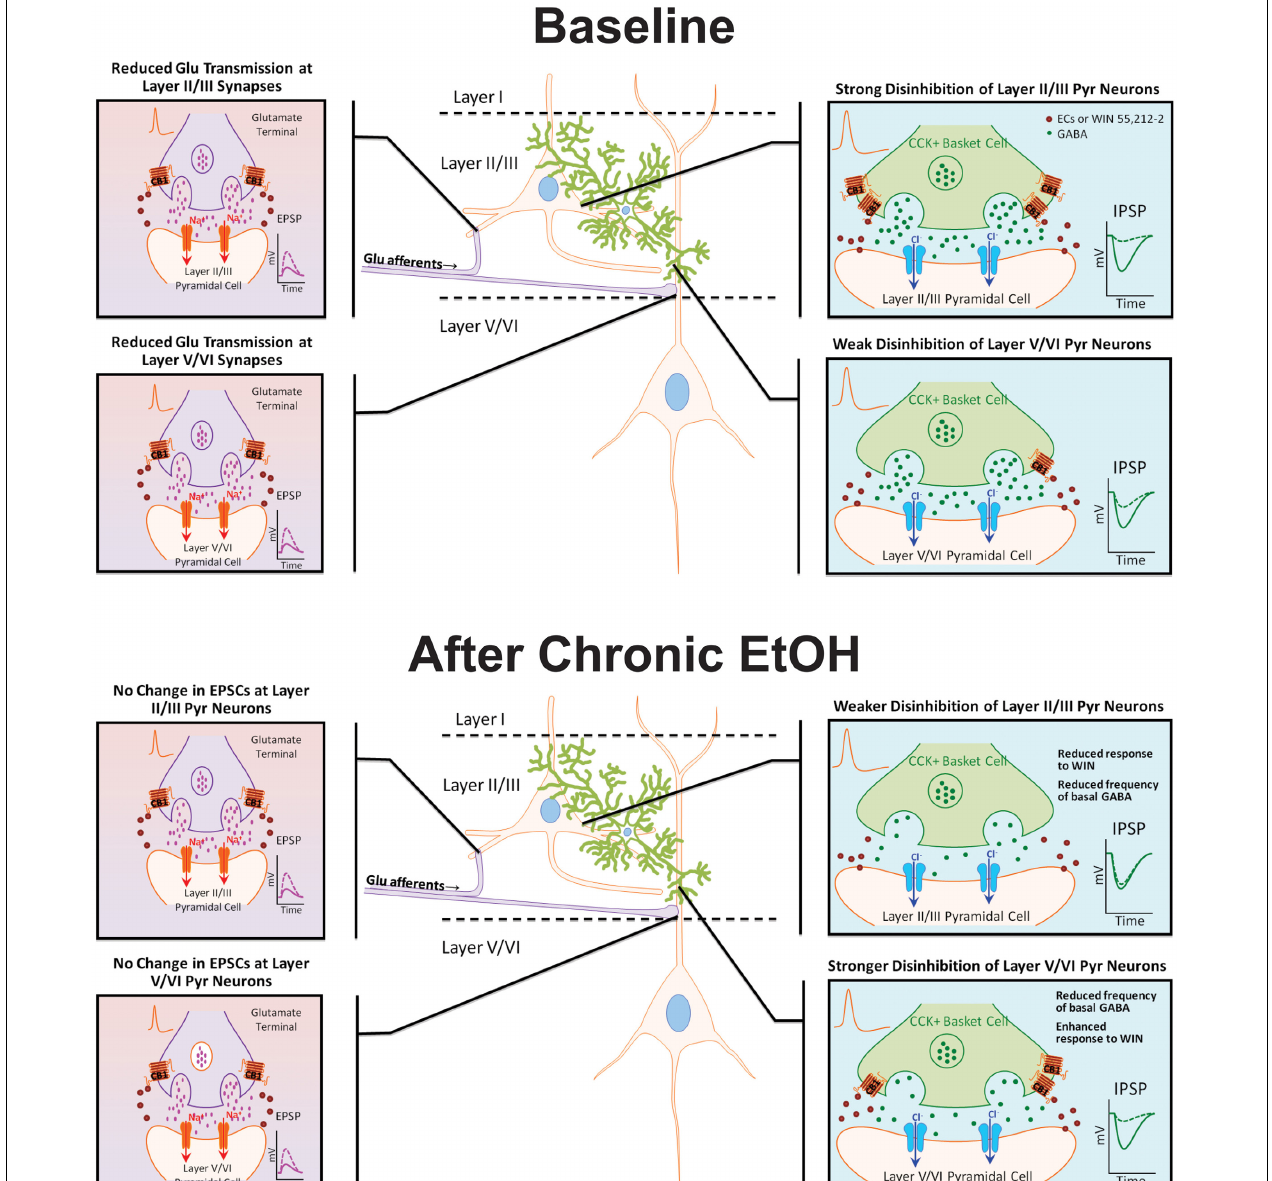
FIGURE 6 | Model diagram summarizing the effects of CB1 activation on specific synapses under basal conditions and following chronic EtOH treatment. Under baseline conditions, CB1 activation reduces GABAergic and NMDA receptor-mediated glutamate transmission at synapses on layer II/III and layer V/VI PNs. The inhibition of GABAergic transmission onto layer II/III PNs is much greater than at GABA synapses on layer V/VI neurons. There is no difference in the inhibition of glutamate transmission between layers. Following chronic EtOH treatment, the